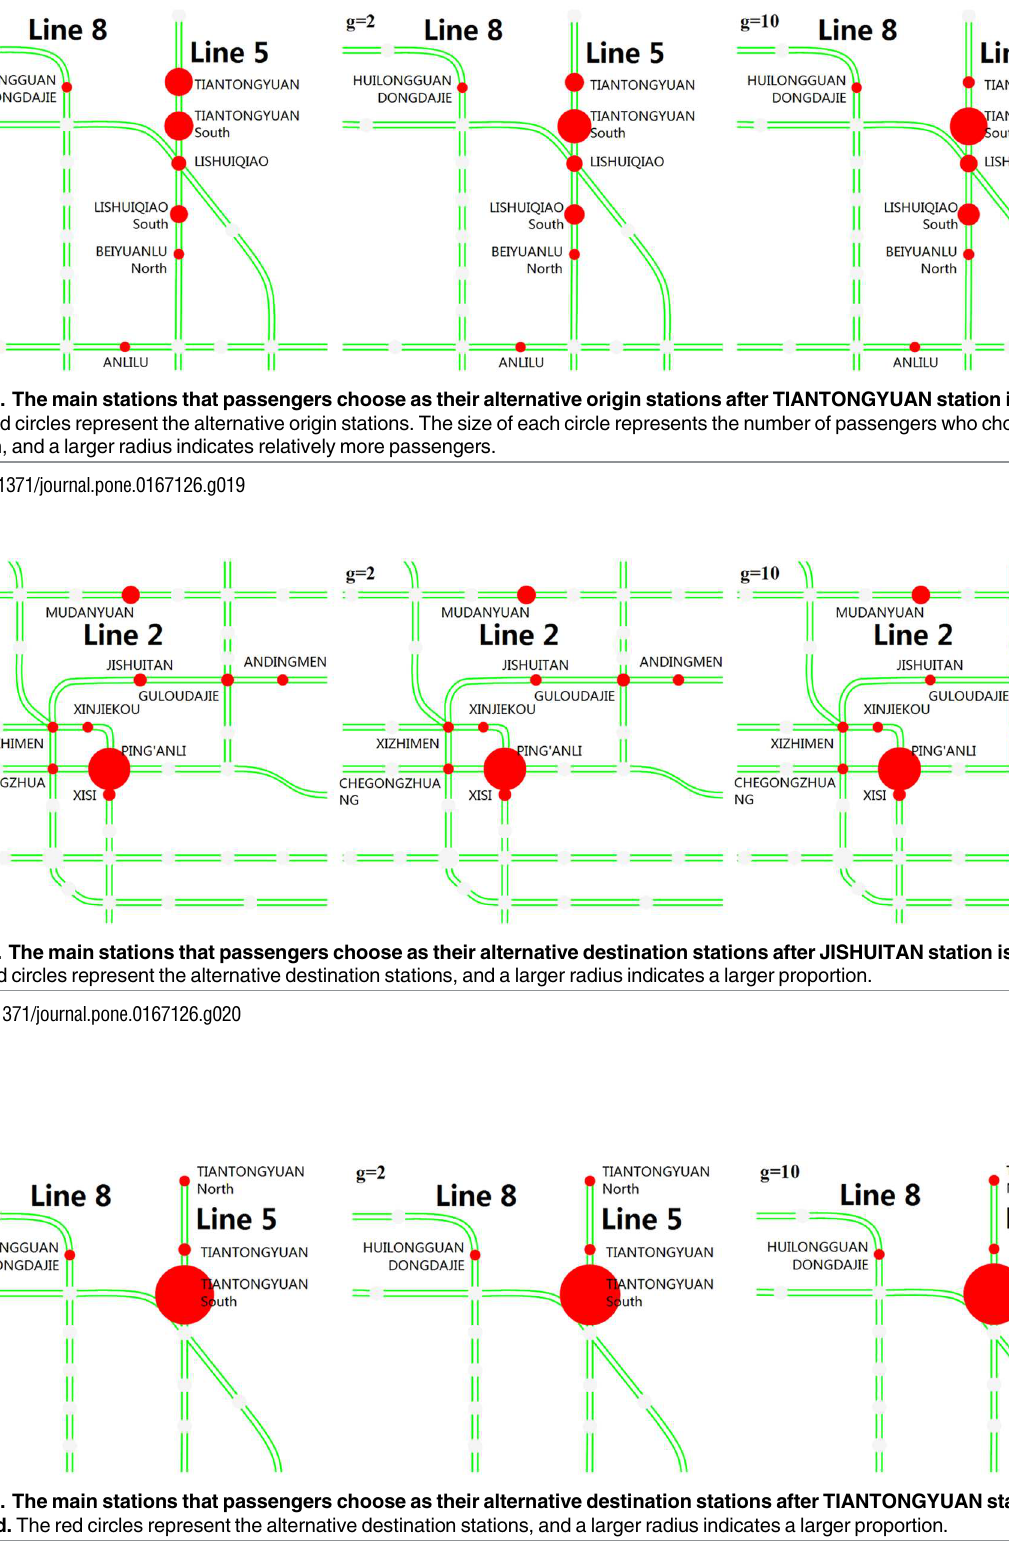
PLOS ONE | DOI:10.1371/journal.pone.0167126 December9,